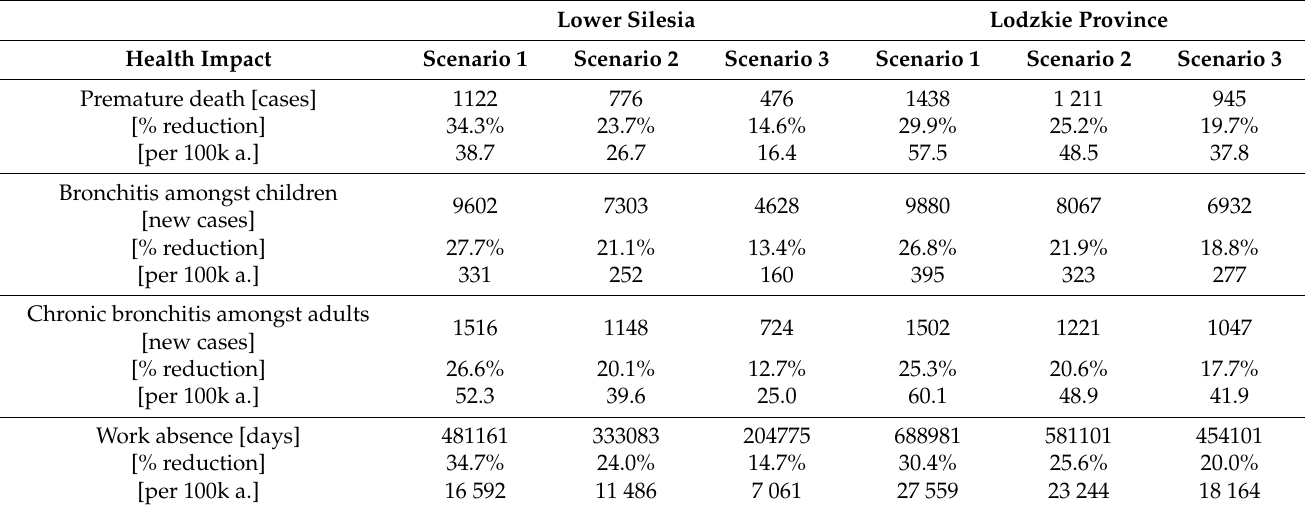
Table 6. Annual health impact reduction per scenario and region. Lower Silesia Lodzkie